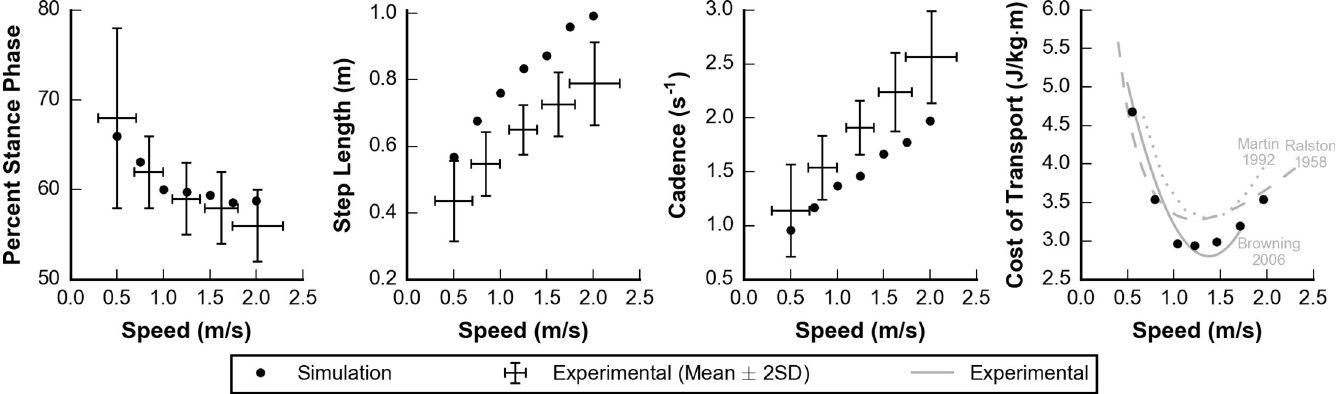
Fig 5. Spatiotemporal and metabolic parameters over a range of speeds. Simulated (dots) and experimental (lines) data are plotted for percent stance phase (left), step length (middle left), cadence (middle right), and cost of transport (right). Experimental data for the left three panels represent the mean ± 2 standard deviations from Schwartz et al. [58]. In the right panel, the magnitude and characteristic shape of the cost of transport bowl were similar between the simulated data and three experimental data sets from Ralston, Martin et al., and Browning et al.